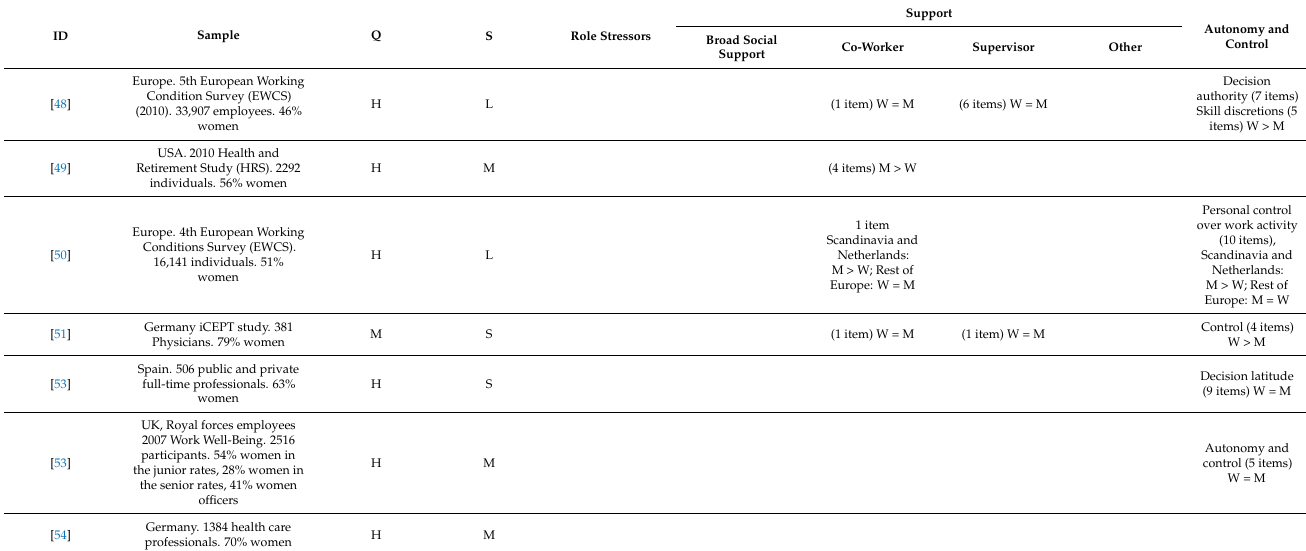
Table A2. Overview of the papers included in the literature review. Panel